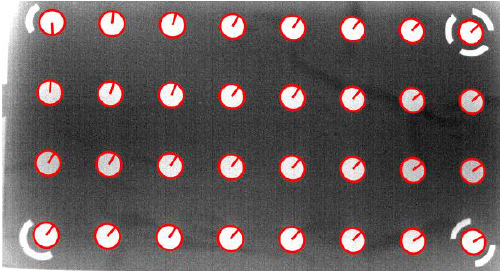
Figure 5. An example of extracting calibration features (centers of circular targets) for a thermal